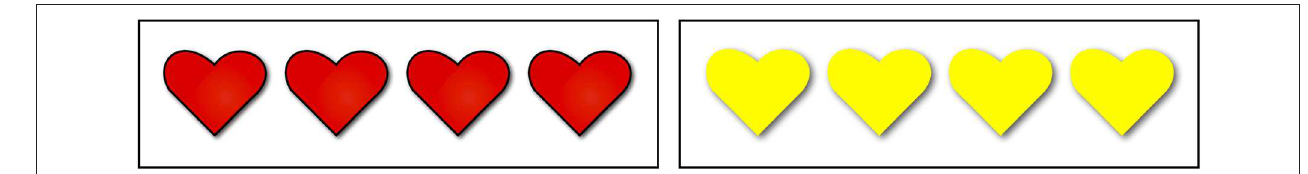
FIGURE 10 | Images corresponding to the clearly true and clearly false definite plural controls. When accompanied by the ALL context image on the left, in which all four hearts are red, the positive and negative descriptions in (23) would be associated with a maximal reward target and a minimal reward target, respectively. When accompanied by the NONE context image on the right, in which all four hearts are yellow, the positive and negative sentences in (23) would be associated with a minimal reward target and a maximal reward target,